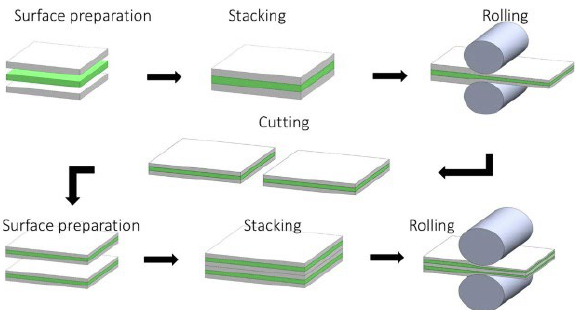
Figure 14. Diagrammatic representation of the accumulative roll-bonding (ARB) process reprinted from ref. [49]. Copyright 2022 ELSEVIER.